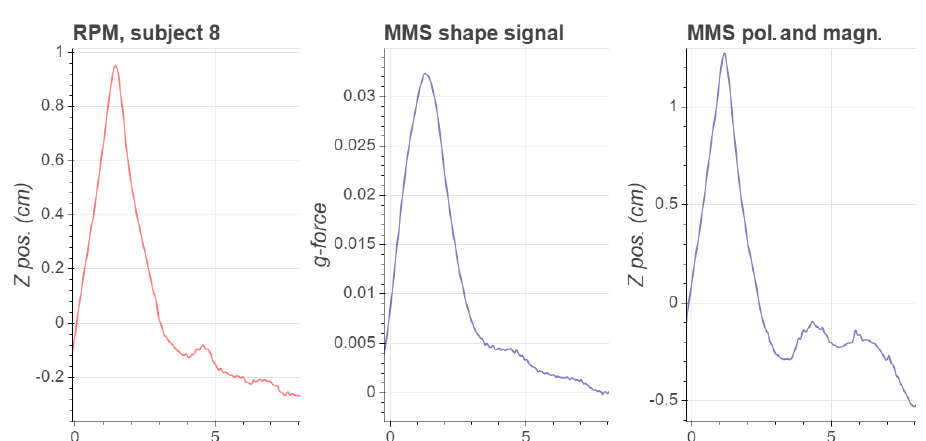
Figure 5. RPM and MMS waveforms corresponding to a single respiratory cycle at scan time t = 0 s–8 s for subject